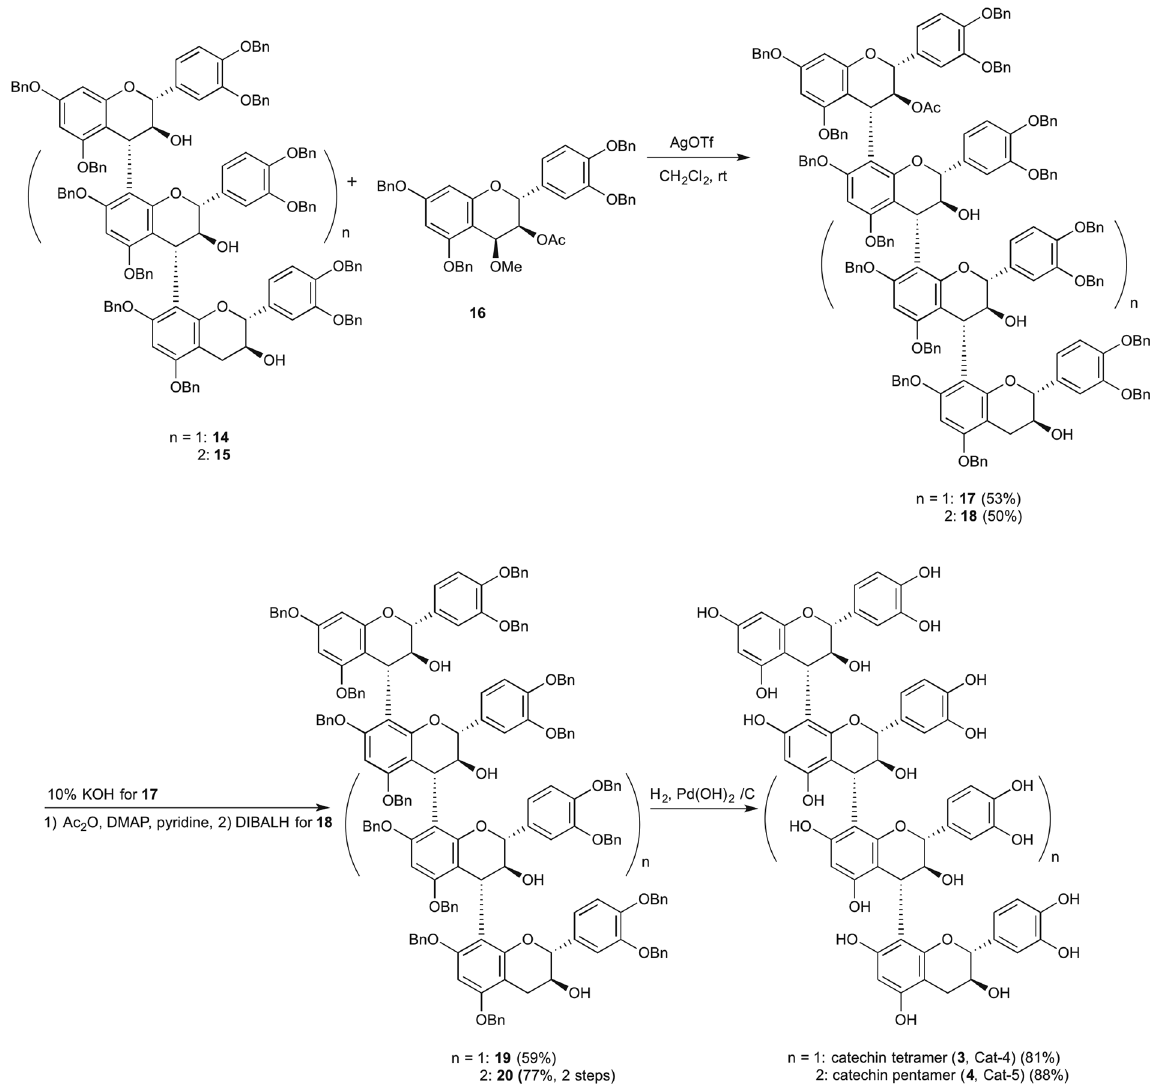
Figure 3. Synthesis of catechin tetramer ( 3 , Cat-4) and pentamer ( 4 , Cat-5). Catechin tetramer ( 3 , Cat-4) and pentamer ( 4 , Cat-5) were synthesized using AgOTf mediated equimolar condensation. AgOTf, silver trifuluoromethanesulfonate, DIBALH, diisobutylaluminium hydride, DMAP, N, N,